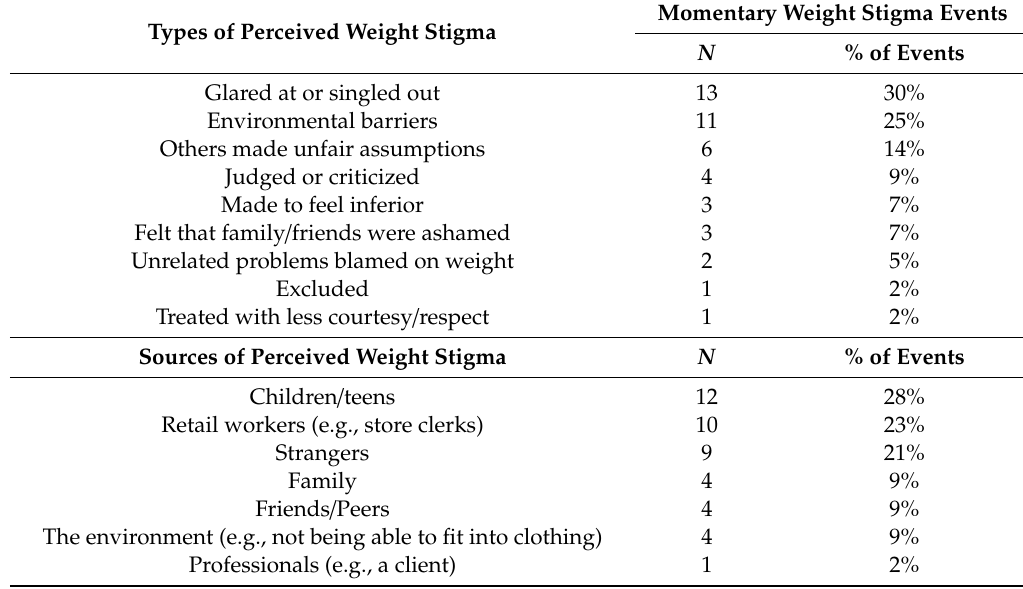
Table 4. Types and sources of perceived momentary weight stigma reported in daily